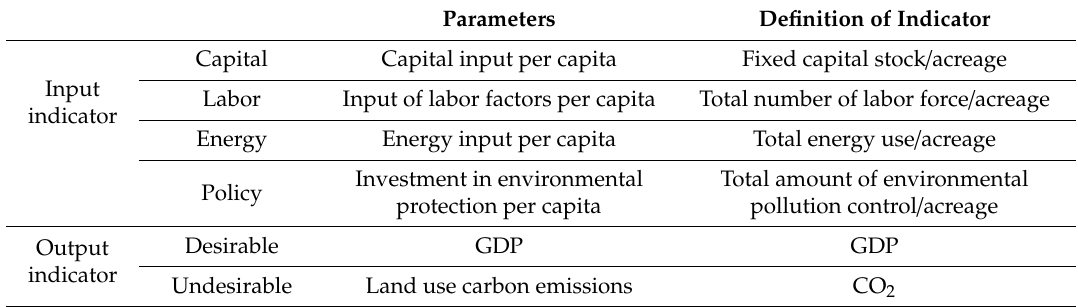
Table 1. Input–output indicator of land use eco-e ffi ciency. Parameters Definition of